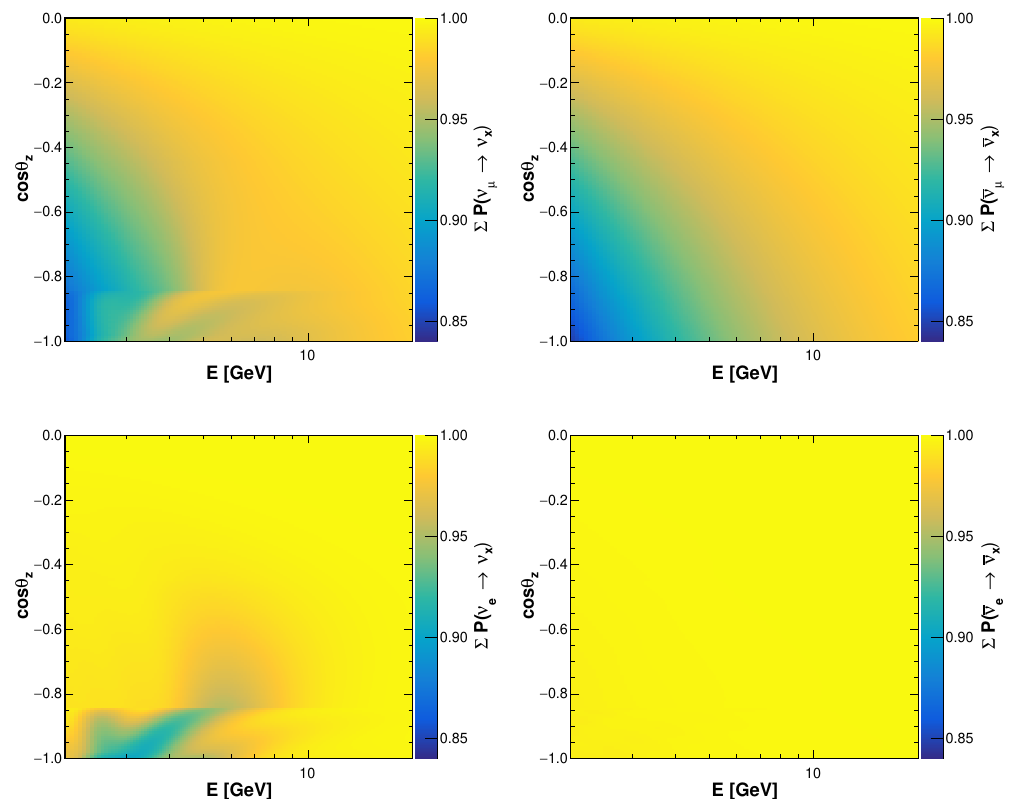
Figure 1. Sum of muon neutrino (top left), muon antineutrino (top right), electron neutrino (bottom left) and electron antineutrino (bottom right) initial flavour probabilities for α 3 = 10 − 5 eV 2 assuming NO as a function of true neutrino energy and the cosine of the true zenith angle. In the case of IO, probabilities can be described by similar patterns but swapping neutrino and antineutrino. The oscillation parameter values are set to their best-fit values according to NuFit 4.1